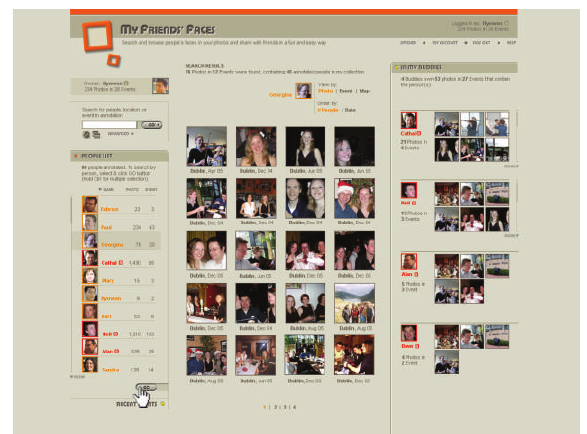
Figure 1: Primary photo access point is the “face index” as fully automatically prepared by the